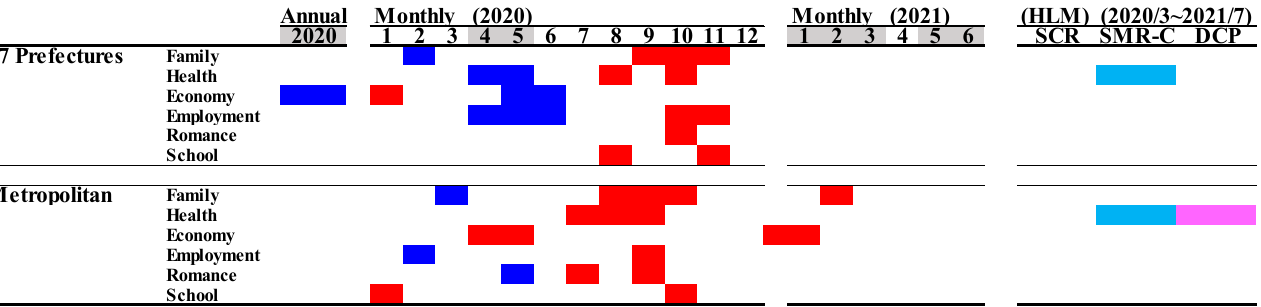
14 of 20 Figure 11. Comparison of annual and monthly SMR-S caused by suicidal motives during the pandemic period to average